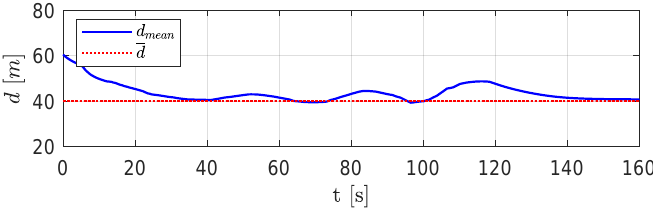
Figure 14. Scenario #1—five aircraft: mean distance between visible aircraft (blue solid line) compared with desired distance (dotted red line).